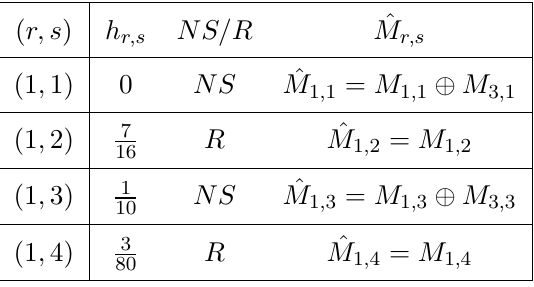
Table 22 . The representations of the super-Virasoro algebra at c = 7 =